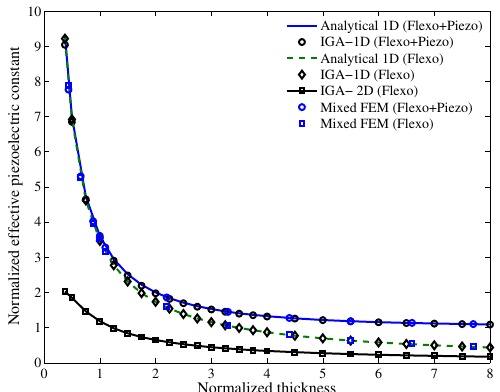
Figure 7. Effective normalized piezoelectric constant obtained with Type-1 boundary condition.